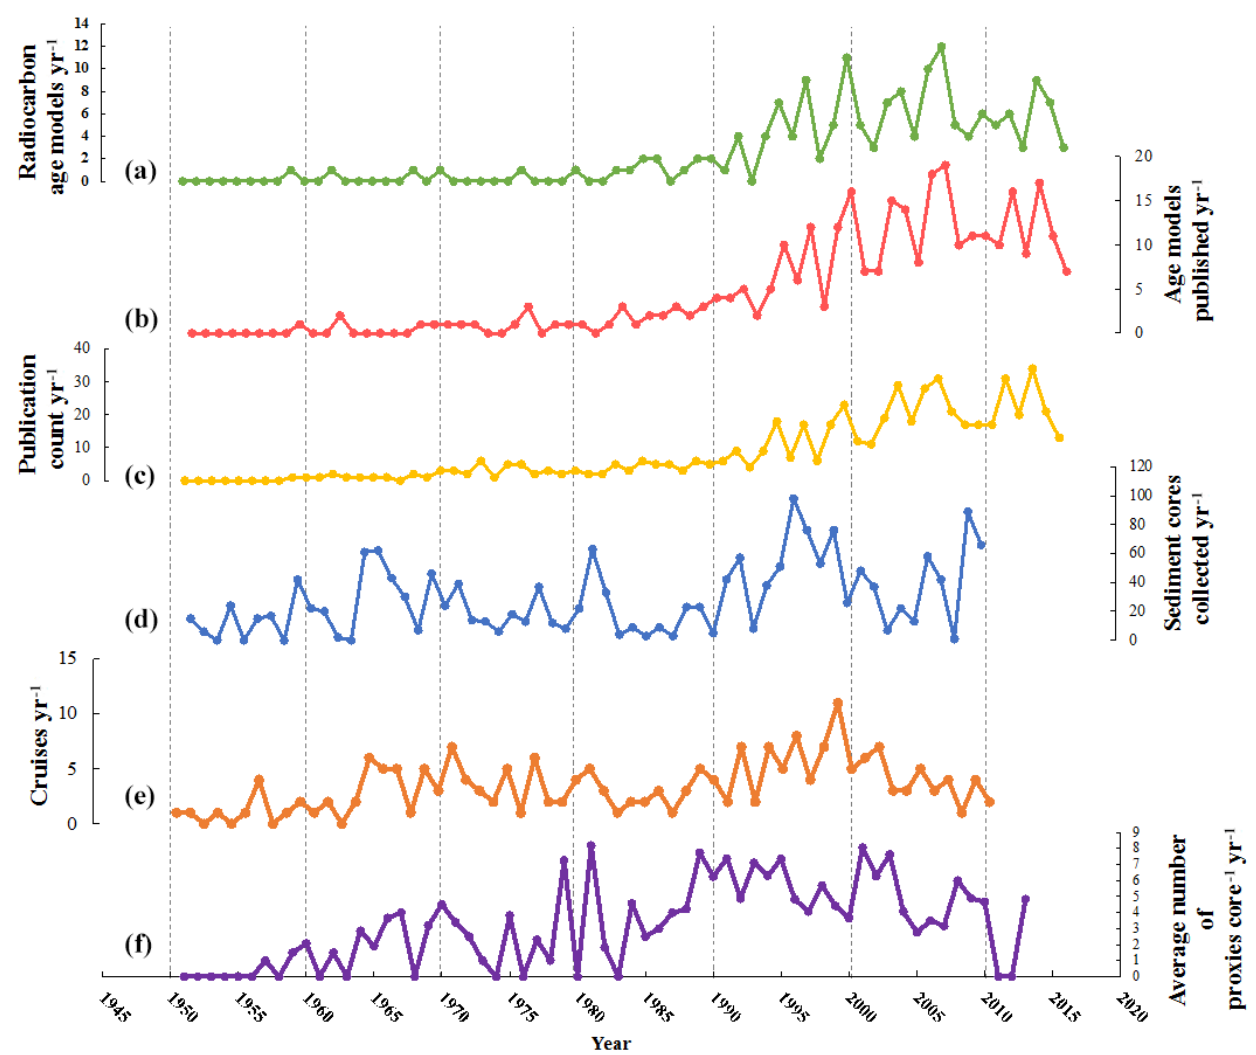
Figure 5. The marine geology cruise and paleoceanographic research progress through time for the North Pacific and marginal seas, wherein the lead–lag timing of cruise reporting and core publication is assumed for the most recent years. We utilize peer-reviewed publications to locate cores, and there is a lag between publication and core extraction. (a) Annual number of age models published using radiocarbon dating. (b) Annual number of all age models published. (c) Total annual number of publications and cruise reports. (d) Annual number of cores collected. (e) Marine research expedition count per year. (f) Annual mean number of proxy analyses published per